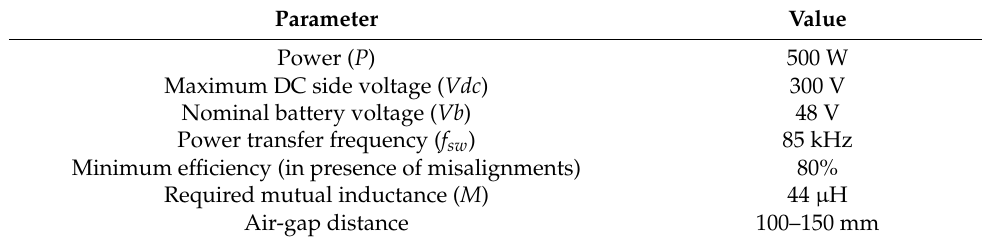
Table 2. General specifications of the 500 W WPT laboratory